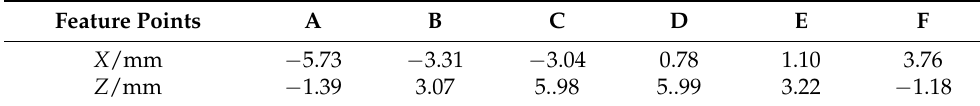
Table 4. Results of precise positioning.